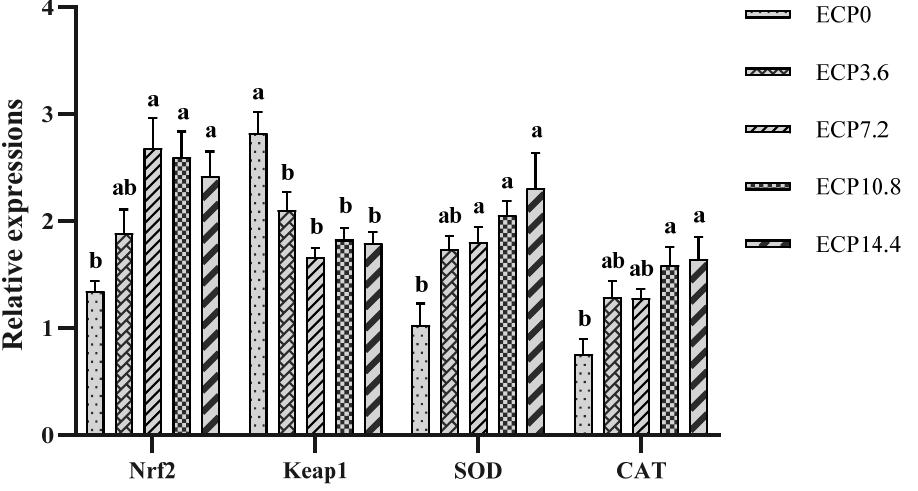
Figure 2. Relative mRNA expression levels of antioxidant genes in liver. Nrf2, nuclear factor erythroid 2-related factor 2; Keap1, kelch-like-ECH-associated protein 1; SOD, superoxide dismutase; CAT, catalase. Data are presented as mean ± SD. Bars with different superscripts indicate significant differences ( p < 0.05), while that with the same letter or no letter superscripts indicate no significant differences ( p >